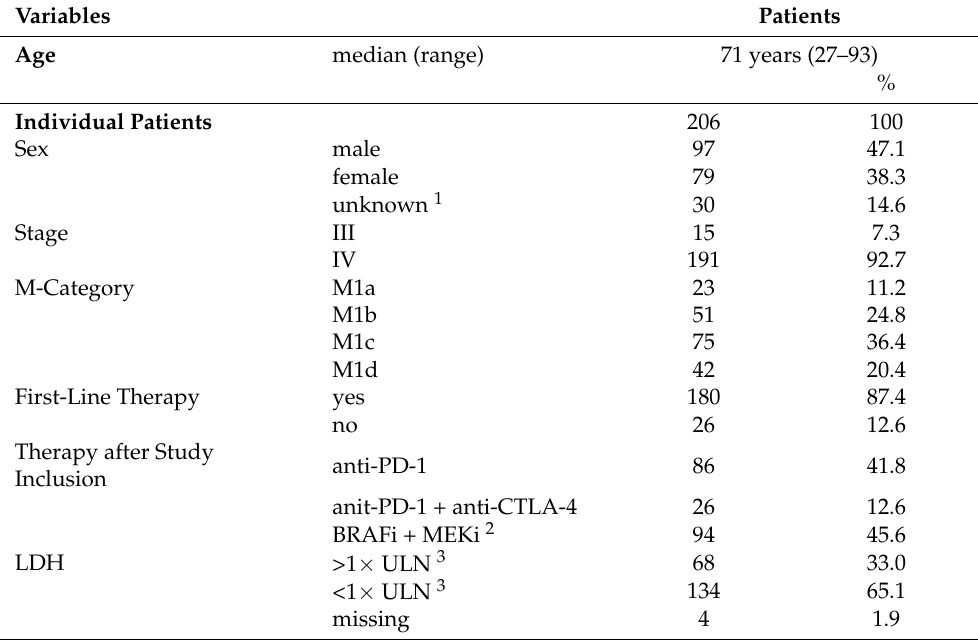
Table 1. Patients included for evaluation of serum ECP, peripheral blood counts and association of REC with response to MAPKi in patients with advanced malignant melanoma receiving dual targeted therapy (total n = 94). Patients receiving immunotherapy served as control cohort (total n = 112). Variables